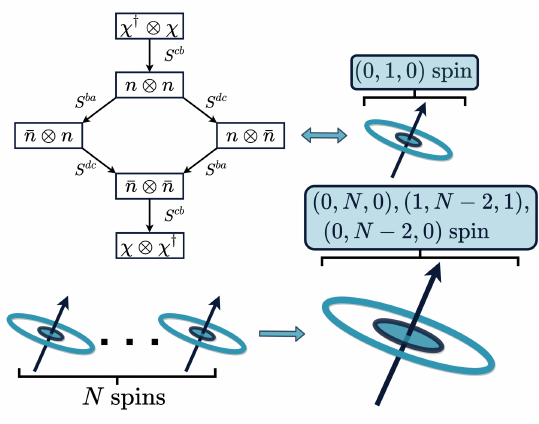
Figure 4 . The six onsite operator-states for the complex Brownian SYK model form the SU(4) irrep (0 , 1 , 0) . Here ¯ n = 1 − n and the construction of the generators is provided in eq. (5.9). The operator dynamics of N complex fermions with charge conservation is mapped to the imaginary time dynamics of N SU(4) spins in the (0 , 1 , 0) irrep, which compose to form (0 , N, 0) , (1 , N − 2 , 1) and (0 , N − 2 , 0) irreps of the global SU(4) algebra as shown in eq. (5.16). In addition, the weights of the global SU(4) spin are also conserved because of the charge conservation. The largest Hilbert space dimension for a fixed weight sector within a given global SU(4) irrep scales linearly with N